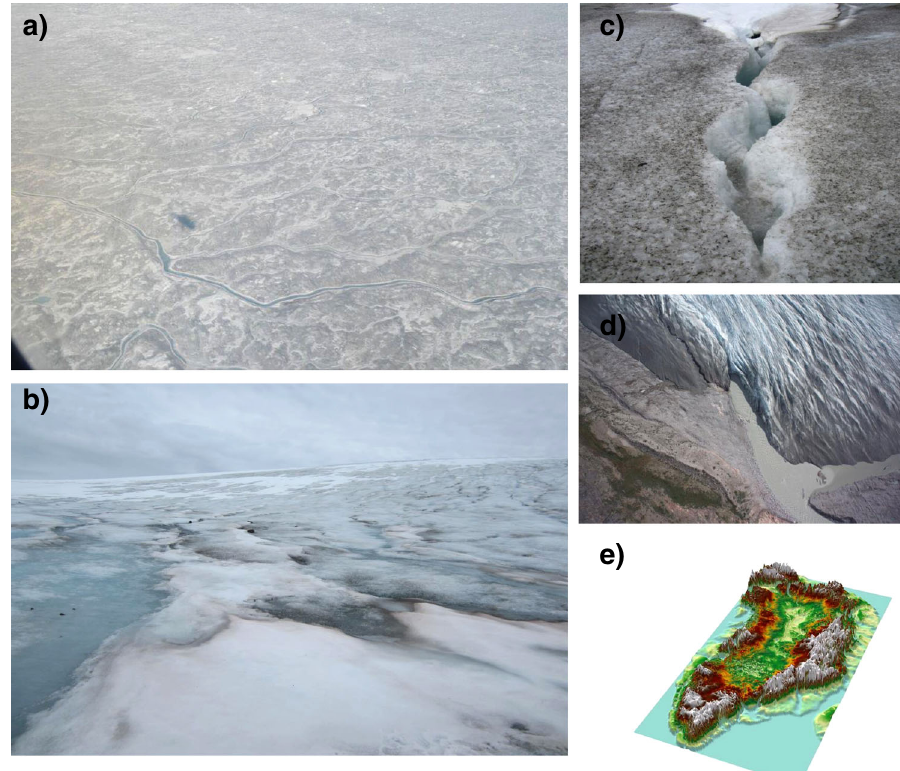
Fig. 1 The different shades of colours and the glacial biome habitats. a Landscape scale view of the west side of the Greenland ice sheet (GrIS) showing the extent of impurities and colonisation of algae at the ice surface; b Photo of a section of the Mittivakkat glacier in the southeast coast of Greenland showing a variety of different surface habitats, from clean snow to “ dirty ” ice; c a small crevasse on the GrIS. Features like this provide opportunities for transport of material from the ice surface to the englacial system; d runoff from Leveret glacier (west Greenland — Kangerlussuaq) containing a large signature of subglacial water (sediment rich); e 3D visualisation of the canyon under the GrIS (Photo by J. Bamber based on ref. 135). The amount of water stored under the ice is